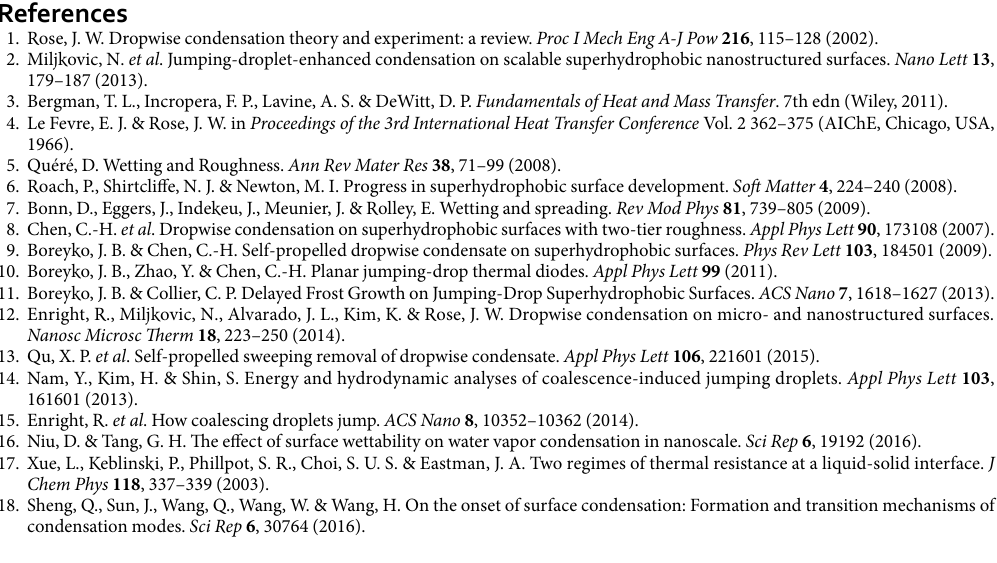
potential function but with length scale σ fs = 0.91 σ and energy scale ε fs = β ε , where the parameter β measures the relative strength of fluid-solid bonding. The vertical, composite nano-surface is arranged leftmost in the simulation box and represented by three layers of solid molecules forming a (111) plane of a face-centered cubic lattice with the lattice constant σ s = 0.814 σ . Neighboring solid molecules are connected by Hookean springs with the constant k = 3249.1 εσ − 2 36 . Two extra layers of solid molecules are set to the left of the three layers. The left layer is stationary as a frame while the right p d i , where p is governed by the Langevin thermostat α = − + + p f F i is the momentum of the i th solid mole- t i i i d cule, α = 168.3 τ − 1 is the damping constant 37 , f i is the sum of the forces acting on the i th solid molecule, F i is a random force, of which each component is sampled from the Gaussian distribution with zero mean value and variance 2 α k B T s / δ t ( δ t = 0.002 τ is the time step, where m / 2 τ σ ε = is the time scale, m being the mass of a fluid molecule) 36, 37 . 1 , followed by the In each run, a relaxation period of 200 τ is used to keep the vapor saturated at ε = . − T k 1 0 B 1 ε = . − and vapor temperature at T k 1 0 1 ε = . − , condensation period of 7000 τ with solid temperature at T k 0 75 s B v B respectively. Extra vapor molecules are supplied through the rightmost supply region (thickness l /10 ) by the x USHER algorithm 38 immediately when the density within the supply region is lower than its initial saturation 1 ε = . − by the value. During the condensation period, the temperature in the supply region is controlled at T k 1 0 v B Langevin thermostat 22, 39 .